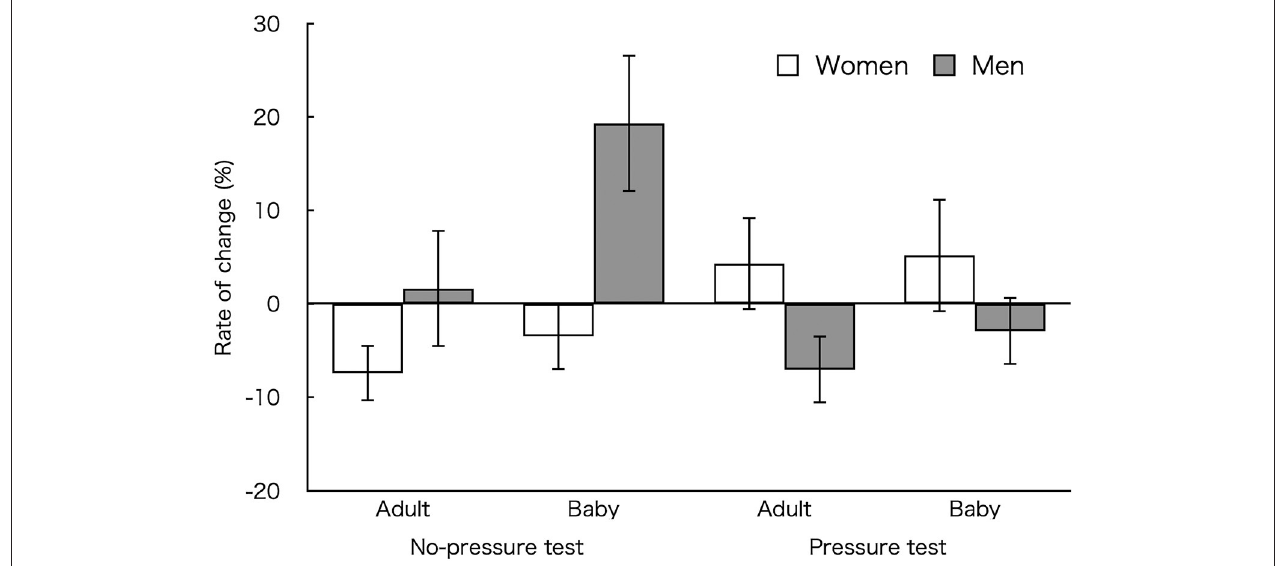
FIGURE 2 | Change rate of percent accuracy in each picture-viewing condition relative to the control condition in each test. Error bars indicate standard error of the mean (SEM).